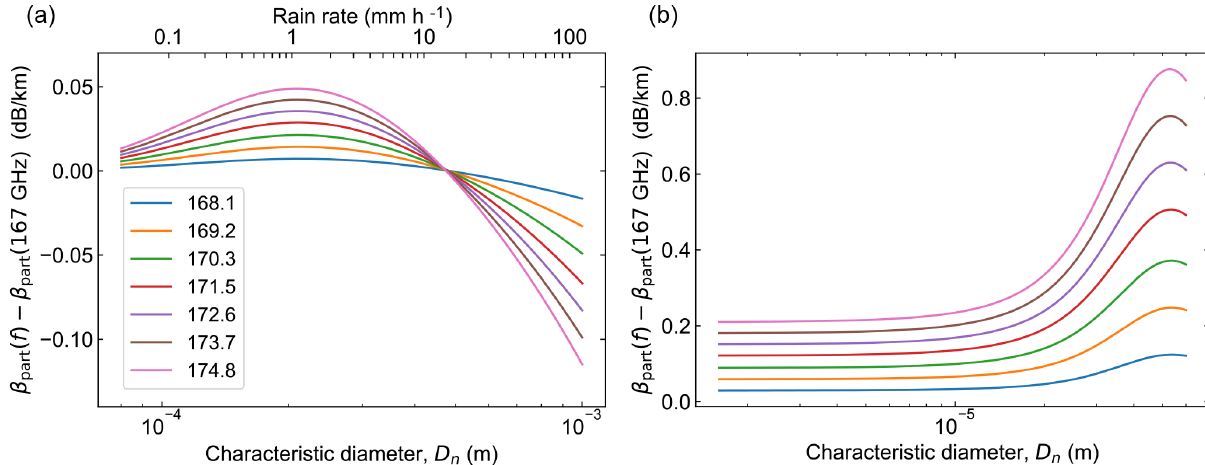
Figure 2. Differential particulate extinction coefficients for (a) rain and (b) cloud. In the case of rain, the DSD characteristic diameter D n determines the liquid water content and hence the rain rate, while for clouds we fix L = 500mgm − 3 . The legend in (a) gives the corresponding frequencies in GHz.